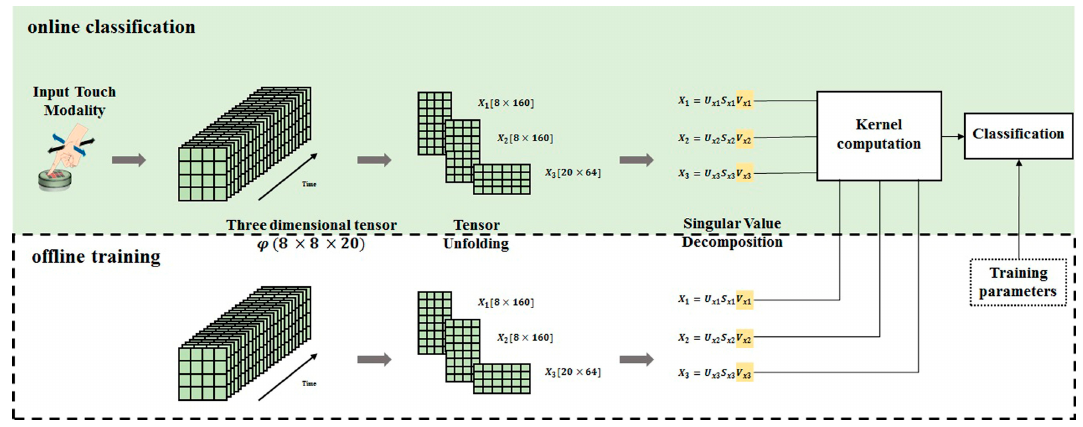
Figure 3. Computation steps for the tensorial kernel approach.